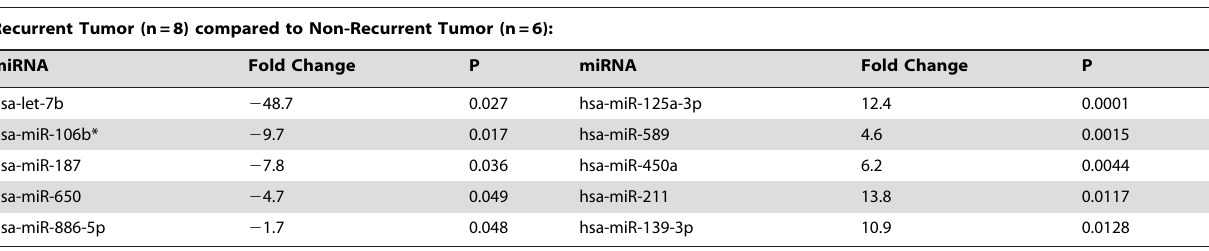
Table 3. Regression analysis of miRNA in non-recurrent and recurrent tumor relative to their normal adjacent